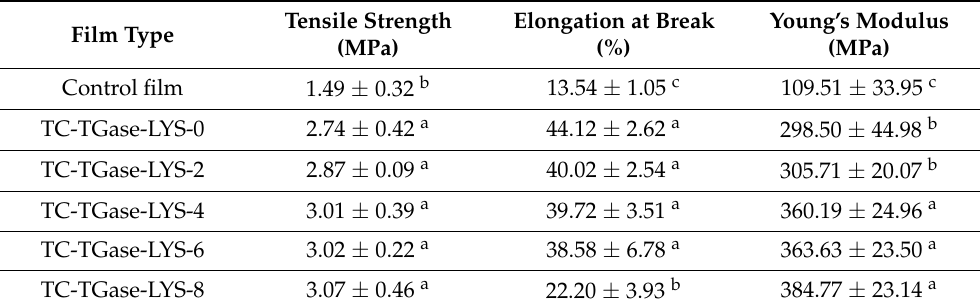
Table 3. Mechanical properties of transglutaminase (TGase) cross-linked tilapia collagen (TC) films incorporated with lysozyme